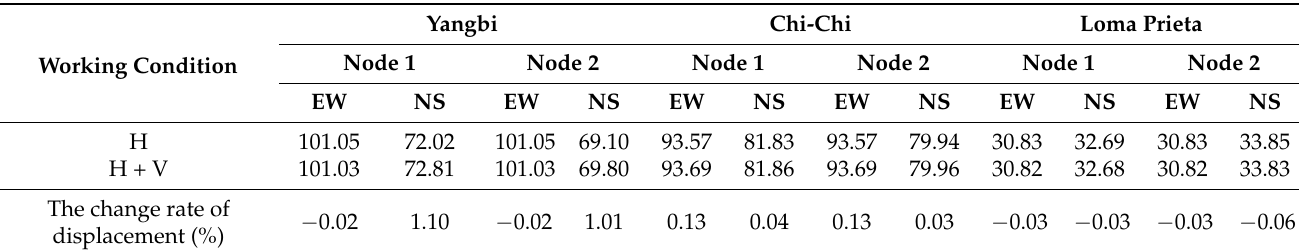
Table 2. Maximum displacement of the top layer in the EW and NS directions/mm.